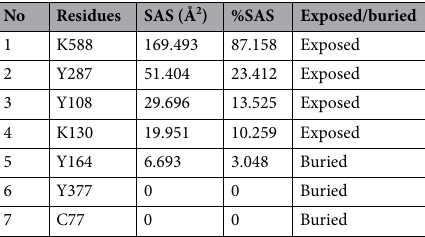
Table 9. The solvent accessibility of labeled residues in HSA